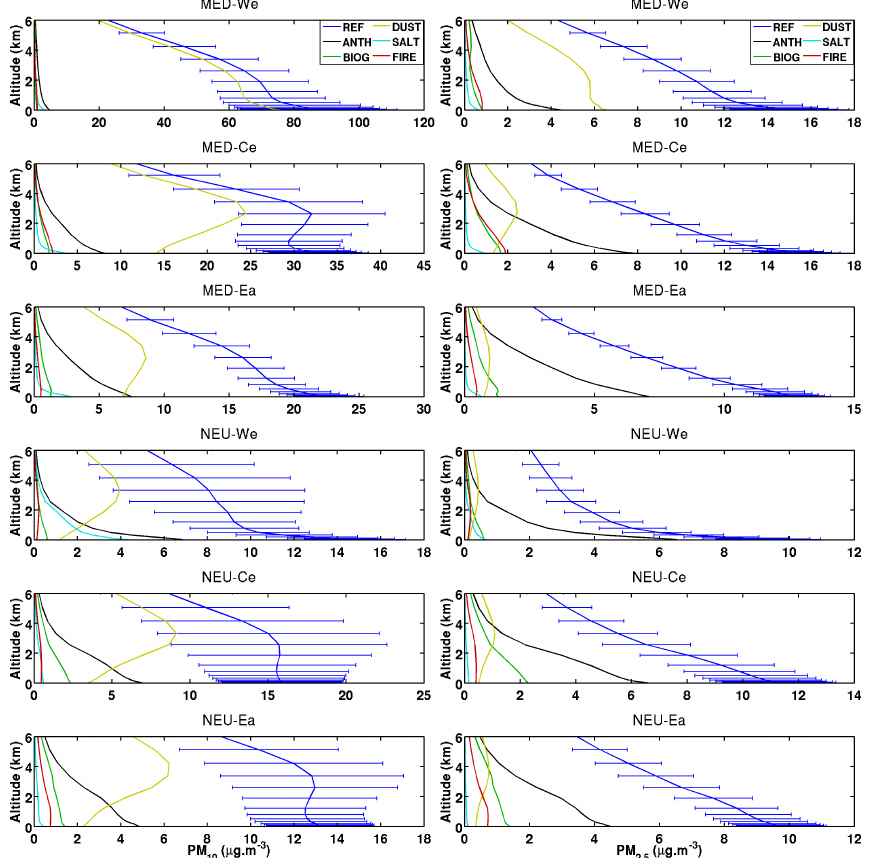
Figure 12. Mean vertical profiles of PM 10 (left column) and PM 2 . 5 (right column) for each sub-region indicated in Table 1 and for each source type. The standard deviation is represented only for the reference simulation by the horizontal